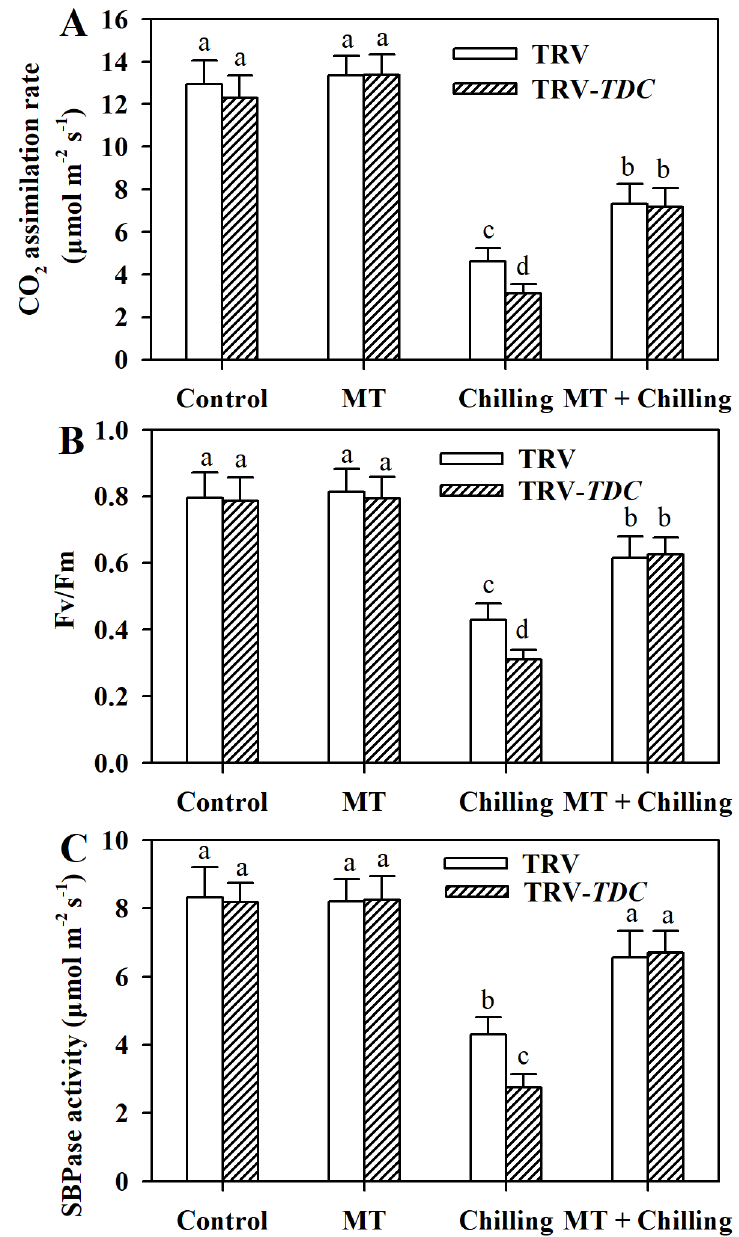
Figure 6. Changes in photosynthesis. ( A ) Carbon assimilation rate; ( B ) Maximum quantum yield of photosystem II (PSII; Fv/Fm); ( C ) activity of Calvin–Benson cycle enzyme SBPase as affected by TDC silencing and exogenous melatonin in tomato leaves under chilling stress. Tomato plants at the 6-leaf stage were exposed to chilling stress (4 ° C) for 12 h and leaf photosynthesis was measured using a portable photosynthesis system. Leaf samples were collected for the determination of SBPase activity. The values presented are means ± SDs ( n = 3). Different letters (a–d) above bars indicate